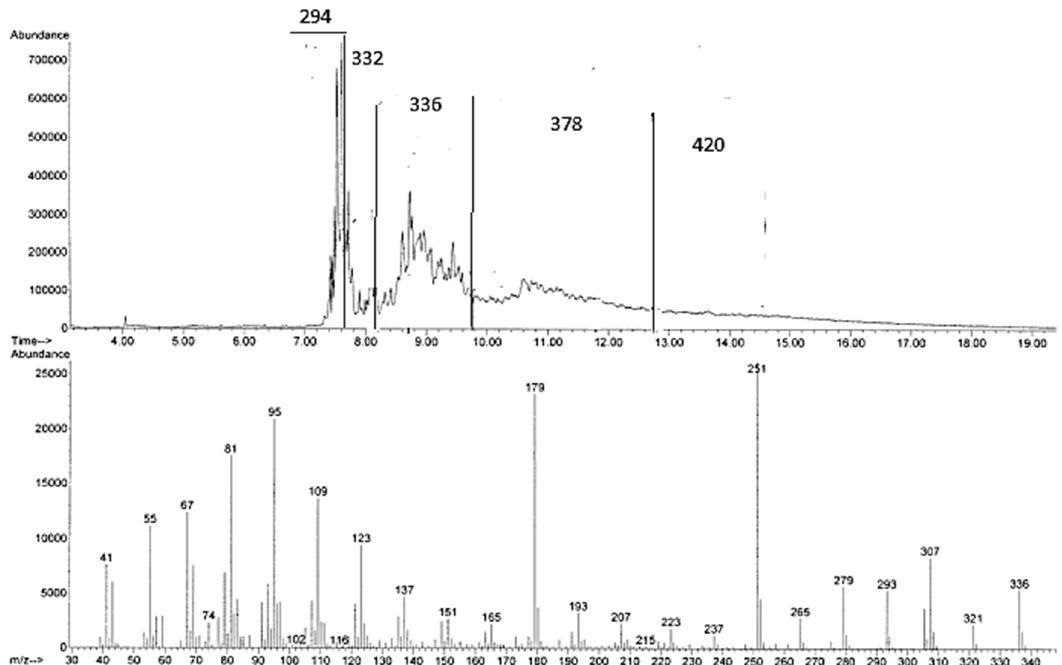
Figure 2. GC-MS chromatogram and MS spectrum of one of the signals with M + 336 arising from the reaction of methyl linoleate with propene in [bmim][Tf 2 N]/Al(Tf 2 N) 3 at 100 °C for 72 h.